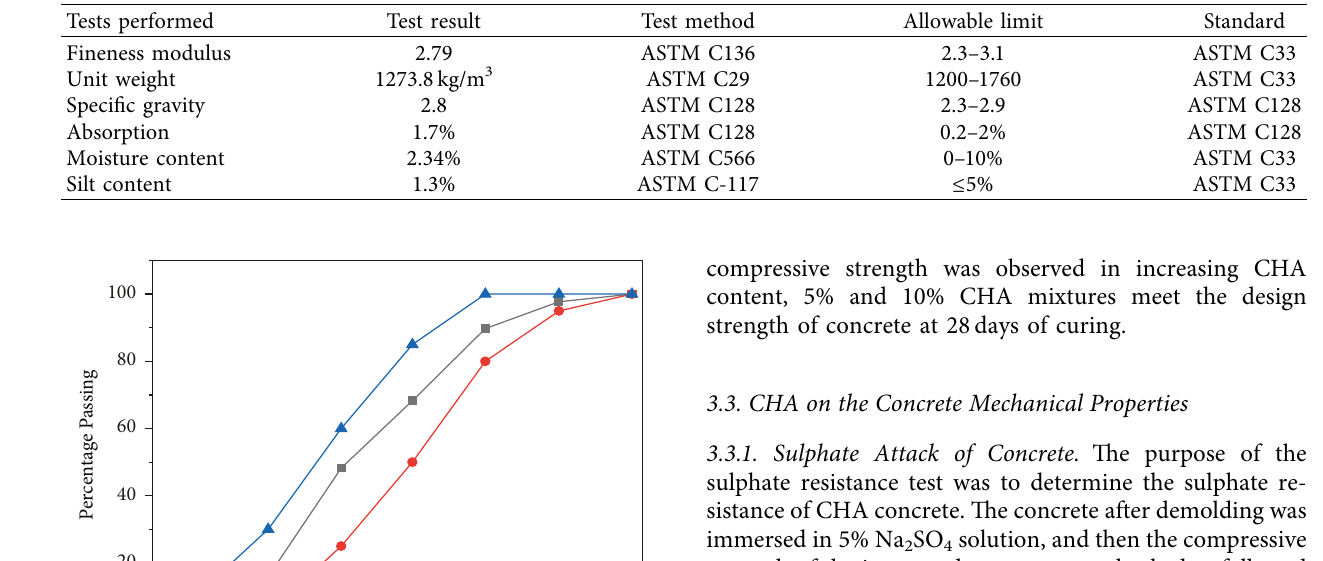
Table 2: Properties of